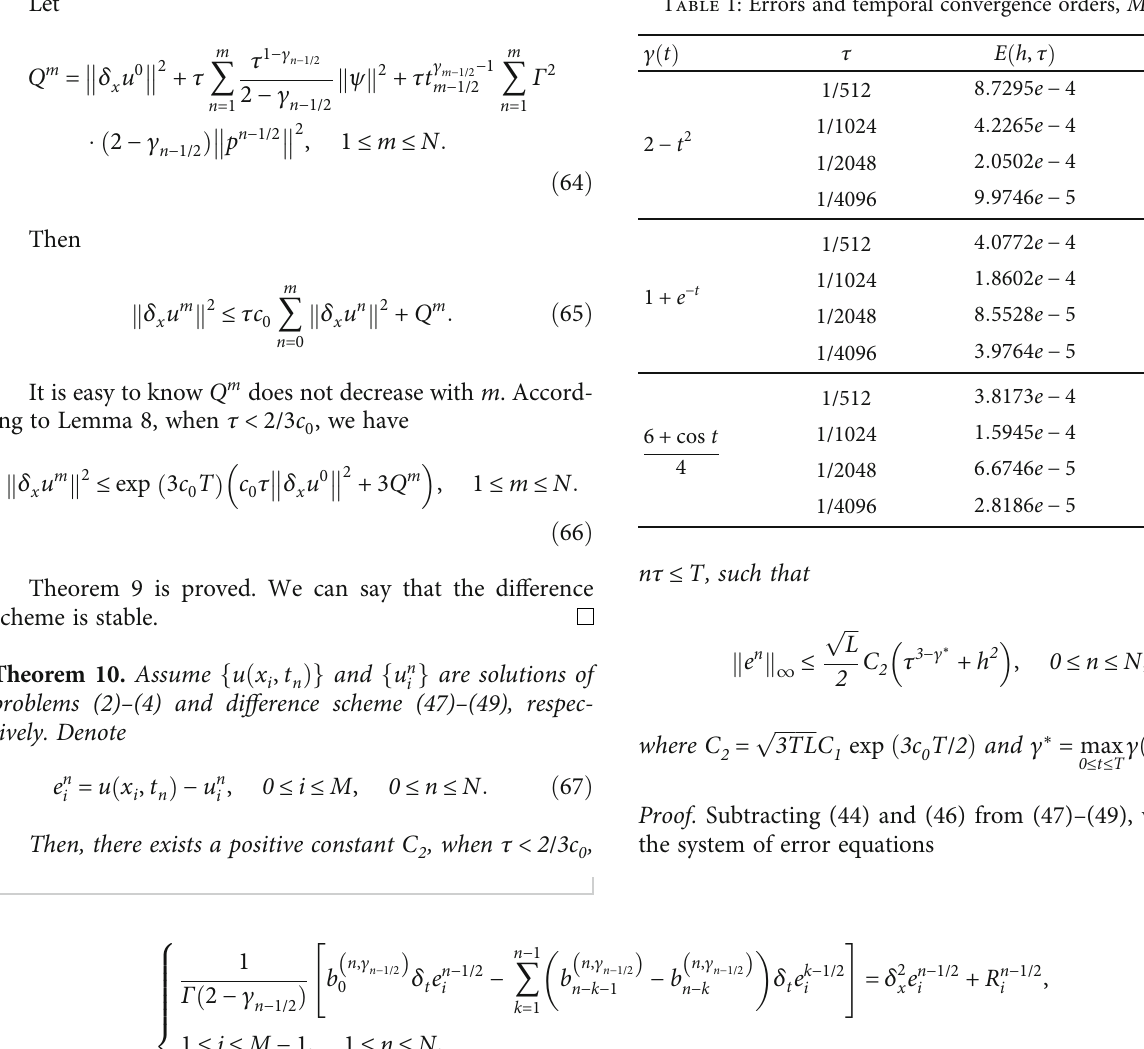
Table 1: Errors and temporal convergence orders, M = 1000